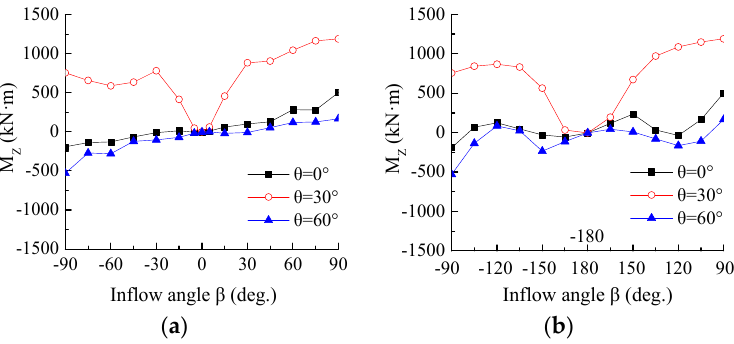
Figure 15. Curves of variation of the averages yawing moment M Z with wind direction: ( a ) The average yawing moment M Z in the wind direction interval ( − 90 , 90 ); ( b ) The average yawing moment M Z in the wind direction intervals ( − 180 , − 90 ) and (90 , 180 ).